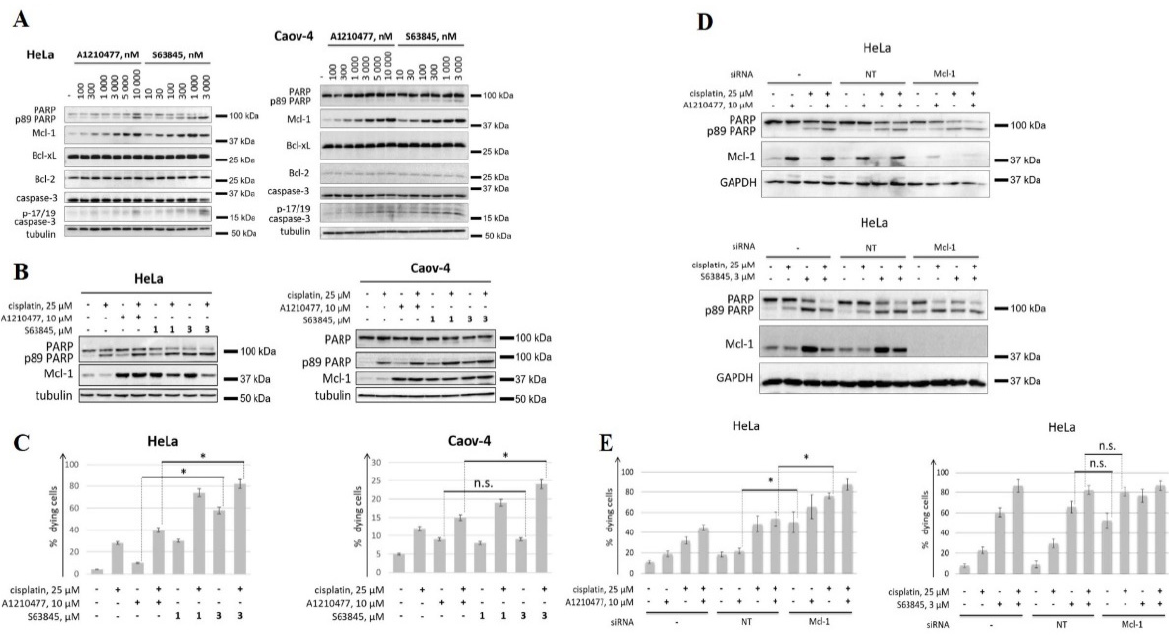
Figure 1. Analysis of the efficiency of BH3 mimetics to Mcl-1, A1210477 and S63845. ( A ) Western blot (WB) analysis of HeLa and Caov-4 cells upon treatment with S63845 or A1210477 at stated concentrations. ( B , C ) WB analysis ( B ) and FACS analysis ( C ) of HeLa and Caov-4 cells treated with 10 μ M A1210477 and 1 or 3 μ M S63845, either alone or in combination with 25 μ M cisplatin. ( D , E ) WB